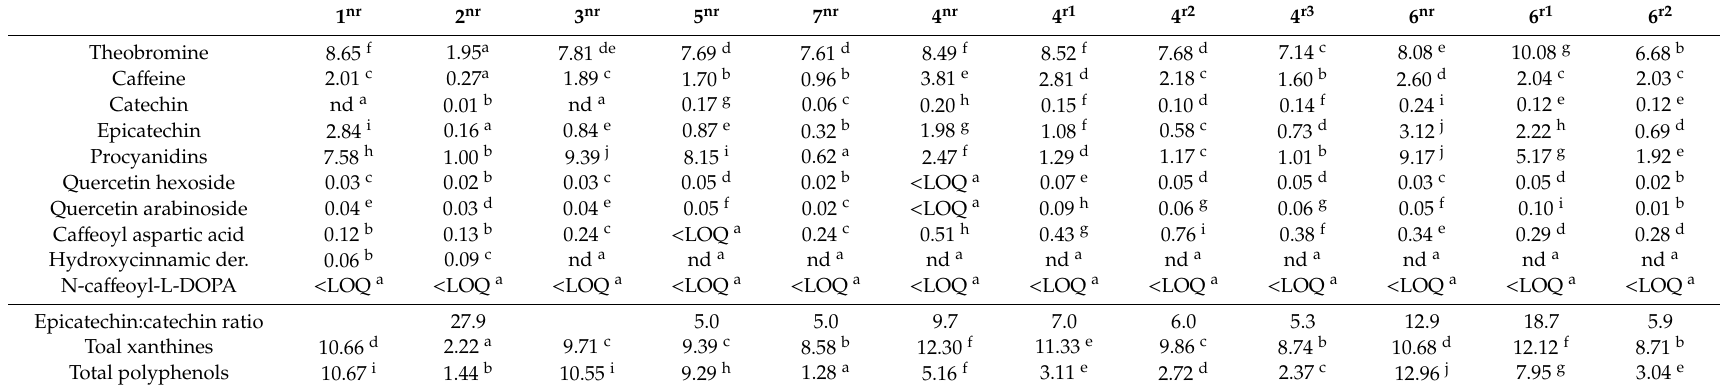
Table 2. HPLC / DAD quantitative analysis of methylxantines and polyphenols in cocoa nibs. Results in mg g − 1 vegetal material. Data obtained from triplicate analysis with relative standard deviation (SD)